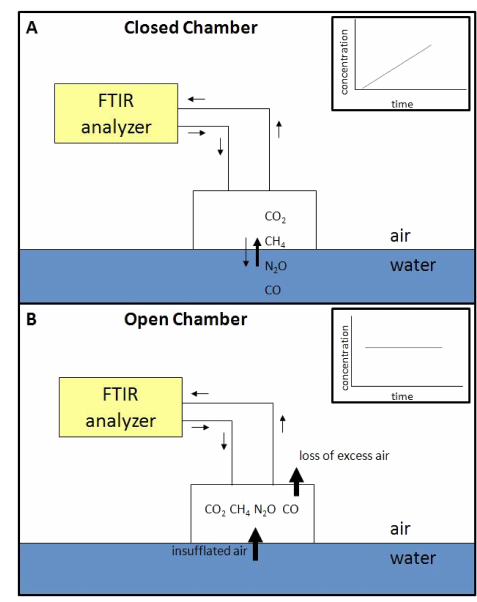
Figure 3. Schematic showing different modes of chamber deploy- ment. (a) Conventional floating chamber used on a calm surface (accumulation closed-chamber measurements). The schematic con- centration vs. time points out how the gas accumulates in the cham- ber over time (in case of a positive net flux from water to air). This increase is linearly approximated and from the slope, the flux is cal- culated. (b) Flow-through open chamber: the excess air escapes and the concentration measured in the chamber relates directly to the concentration in the emitted air. Thus, here we refer to the concen- tration reached in one time